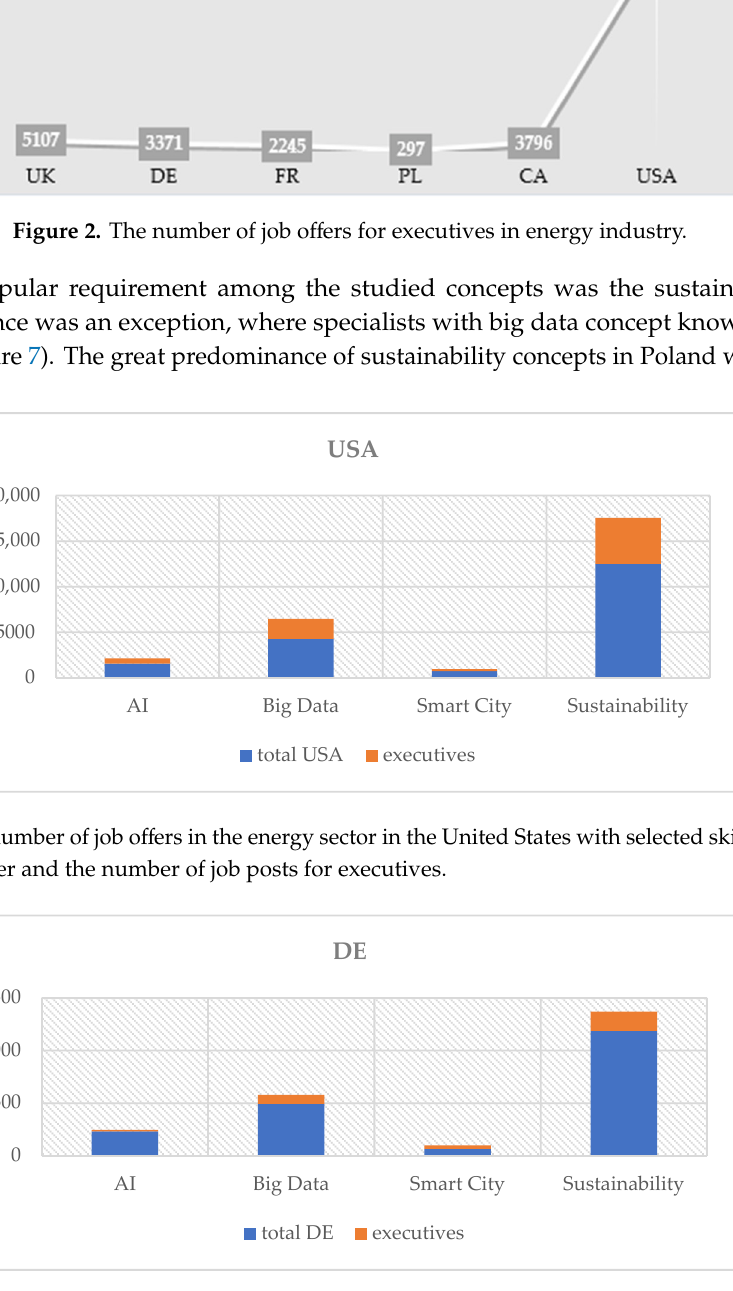
Figure 5. The number of job offers in the energy sector in the United Kingdom with selected skills required: the total number and the number of job posts for executives.